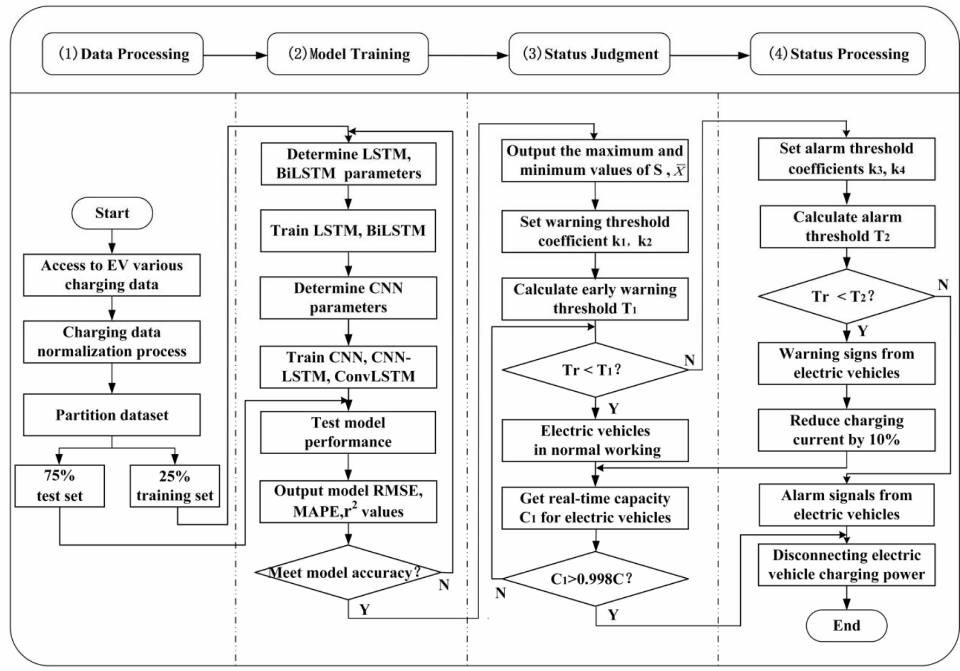
four stages: Data Processing, Model Training, Status Judgment, and Status Processing. The flow chart is shown in Figure 4.